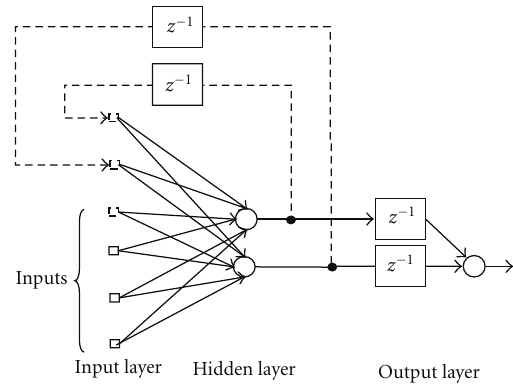
Figure 3: A fully connected recurrent neural network with 4 inputs, a hidden layer with 2 neurons, and 1 neuron in the output